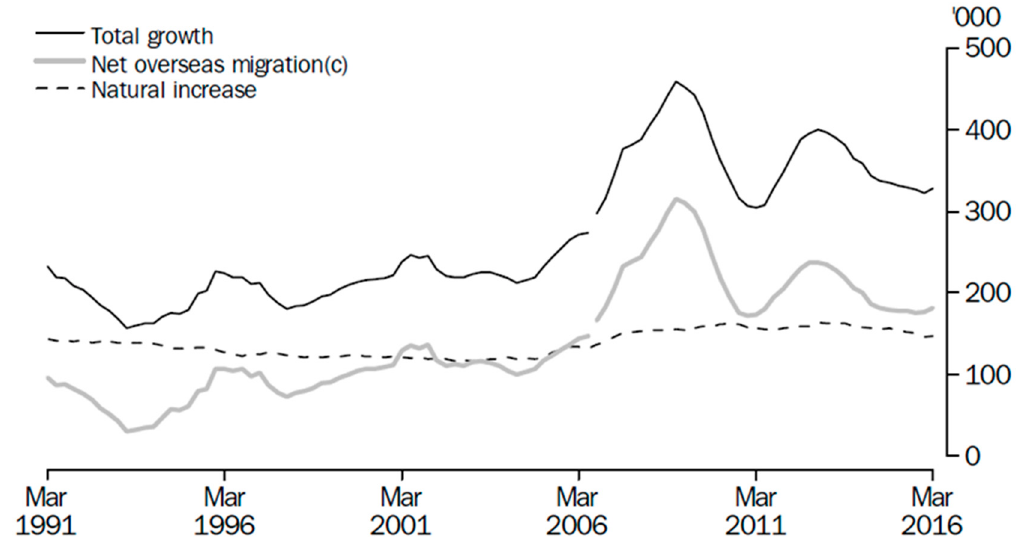
Figure 1. Components of annual population growth. Source: ABS (2016).